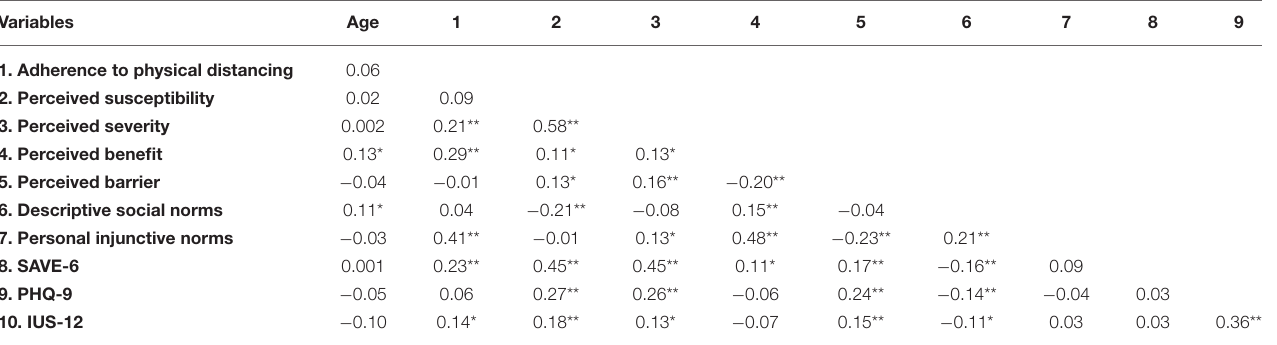
TABLE 3 | Correlation coefficients of each variable in all participants. Variables